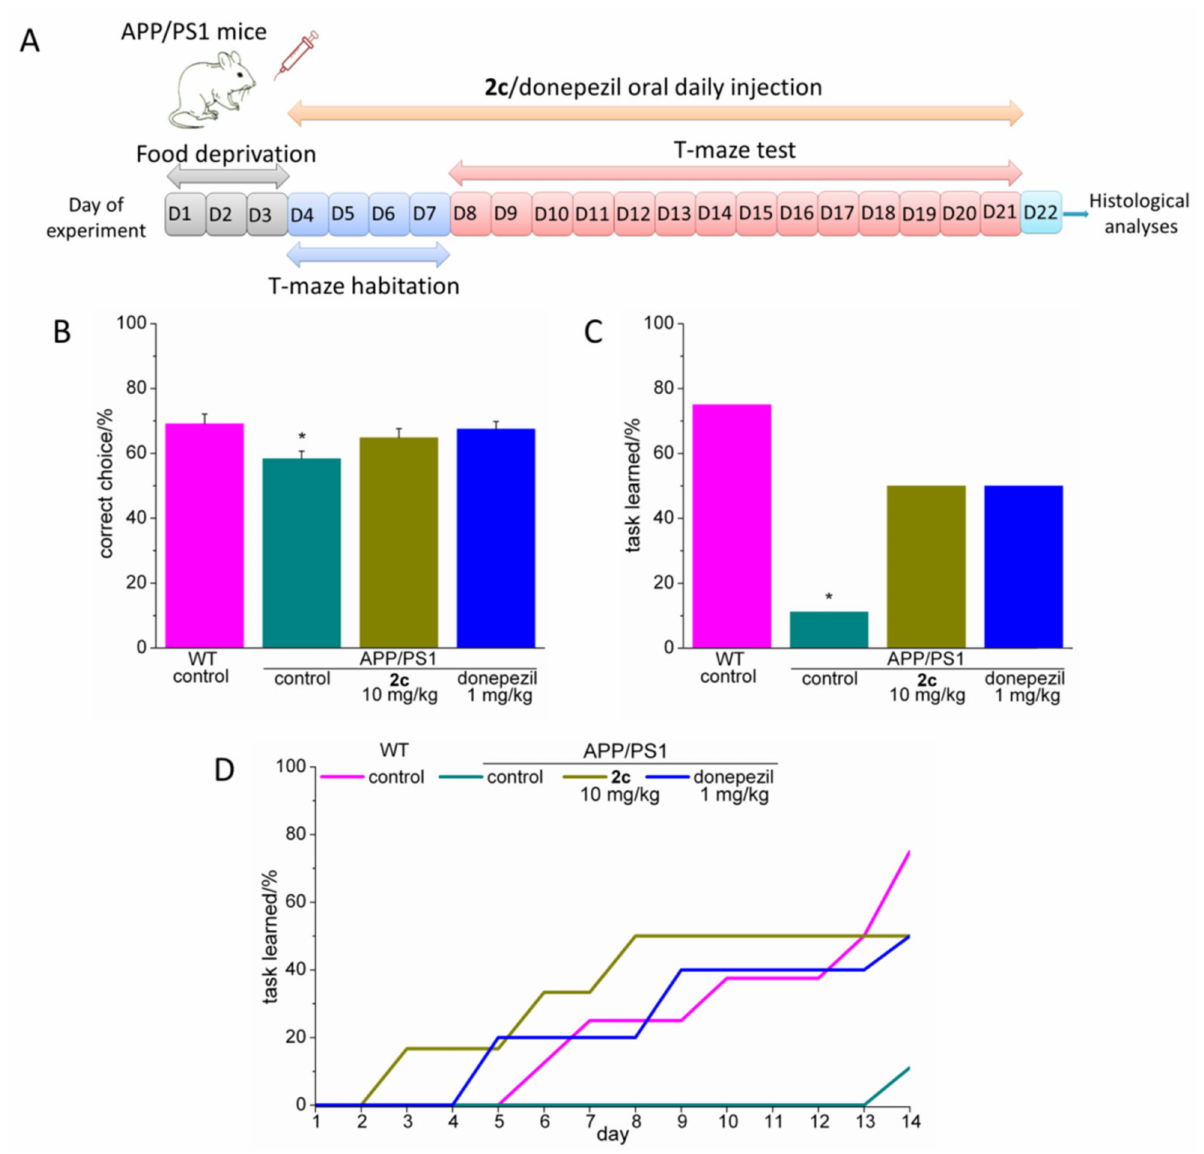
Figure 7. Effect of compound 2c and donepezil on spatial memory performance in T-maze test in an Alzheimer’s disease transgenic model. ( A ) Experimental paradigm: APP/PS1 mice were treated with either compound 2c (10 mg/kg) or donepezil (1 mg/kg) within 18 days during the T-maze test. ( B ) Percentage of correct choices in the T-maze test. Data are reported as mean ± SE. Statistical analysis was performed using the Mann–Whitney test. ( C ) Percentage of mice reaching the criterion of learning the task by day 14 in the T-maze test. Statistical analysis was performed using Fisher’s exact test. ( D ) Dynamic of reaching the criterion of learning the task. * p < 0.05 compared to control